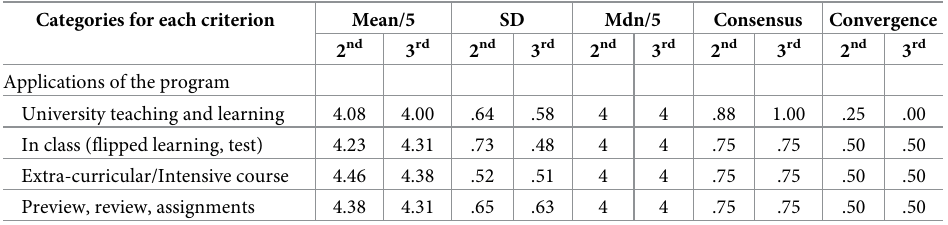
Table 8. Level of agreement with the appropriateness of the questions (second and third Delphi survey results). Categories for each